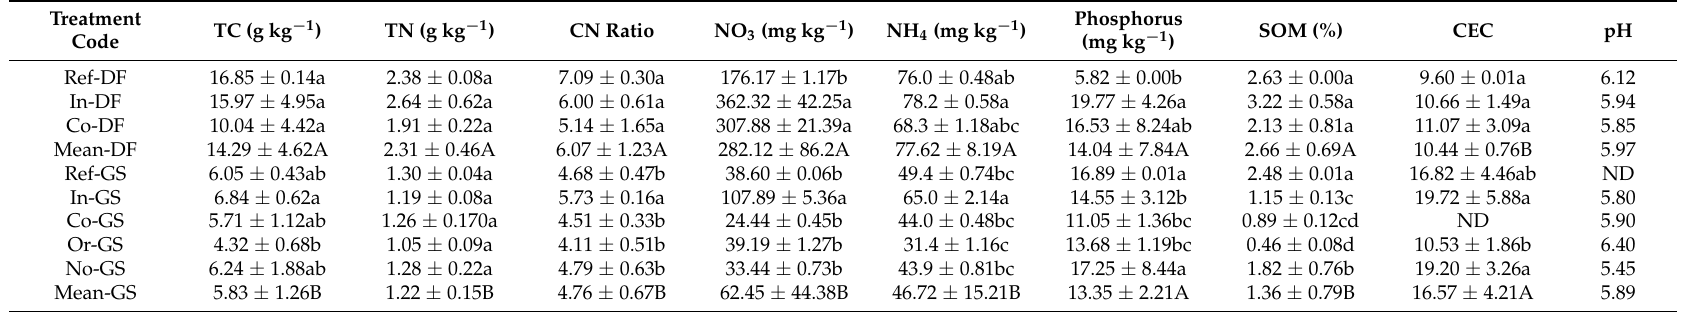
Table 1. Biochemical properties of the studied